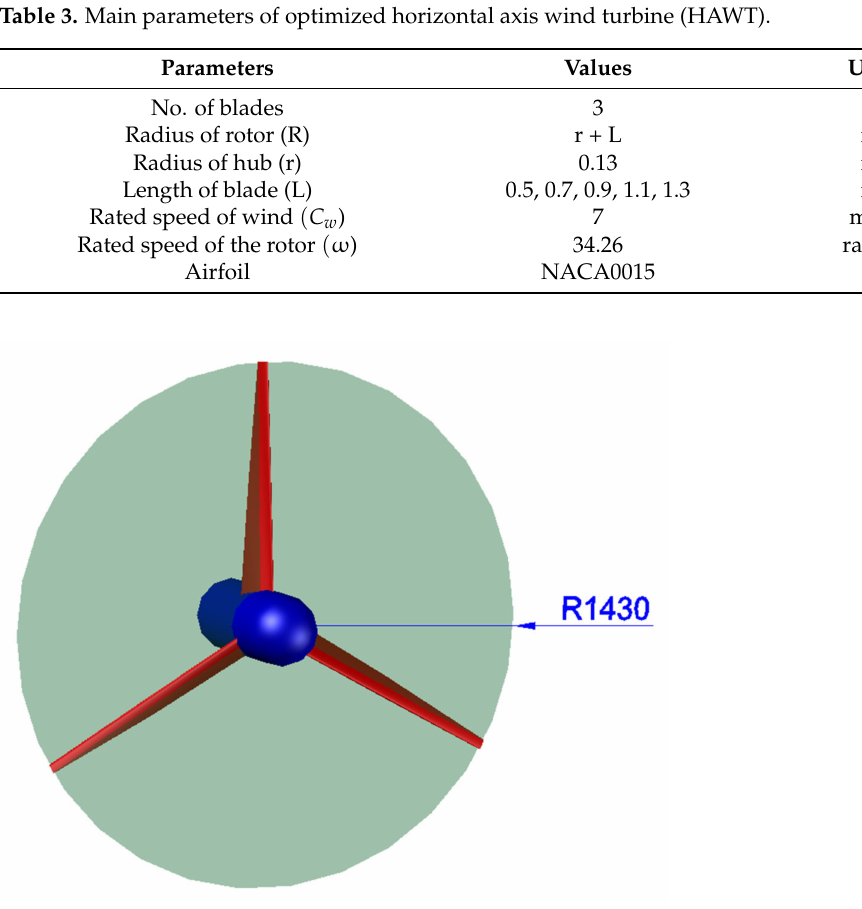
Figure 1. 3D model of geometry of optimized